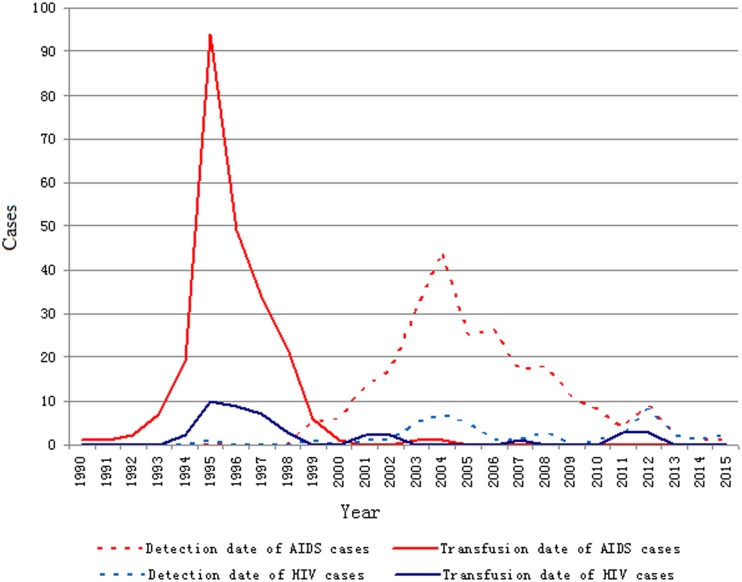
Date of transfusion and detection date of HIV infection.